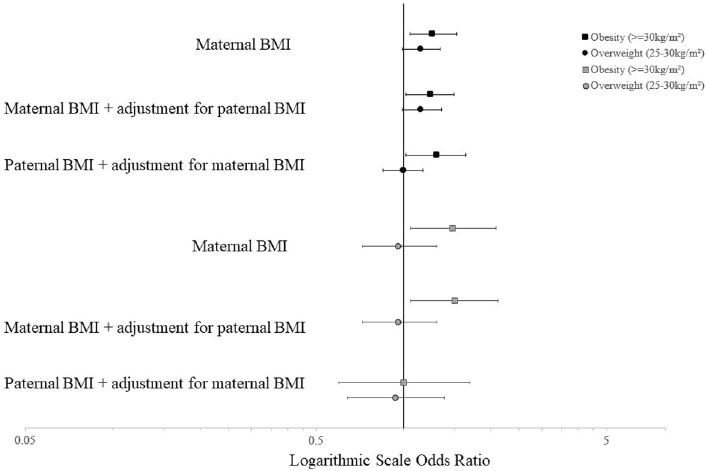
Figure 2. Adjusted odds ratios for a high hyperactivity-inattention symptom score (≥ 7) in 5.5 year old children of the ELFE (n = 10,898; black points) and EPIPAGE 2 cohorts (n = 2646; grey points). a Adjusted for maternal age at birth, maternal education, household income (ELFE), household socioeconomic category (EPIPAGE 2), parity, sex, psychological problems during pregnancy (ELFE), anxiety symptoms (EPIPAGE 2), singleton pregnancy (EPIPAGE 2), maternal physical activity during pregnancy (ELFE), maternal healthy diet score during pregnancy (ELFE), maternal alcohol intake during pregnancy (ELFE), maternal smoking during pregnancy, child age at evaluation, gestational age, breastfeeding, cause of prematurity (EPIPAGE 2) childcare at 2 years, screentime at 2 years (ELFE), HOME score (EPIPAGE 2), difficulties falling asleep at 2 years (ELFE) and frequent night waking at 2 years (EPIPAGE 2). b Missing covariates are imputed and weighted using IPW.